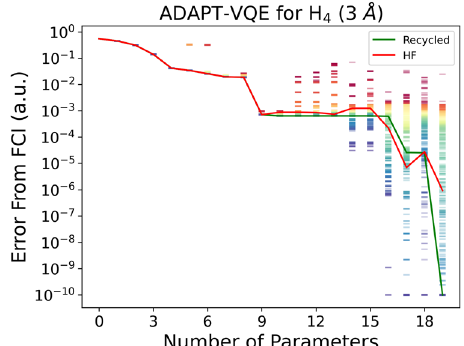
Fig. 2 ADAPT-VQE results for H 4 at 3 Å . The axes and colors are as in Fig.